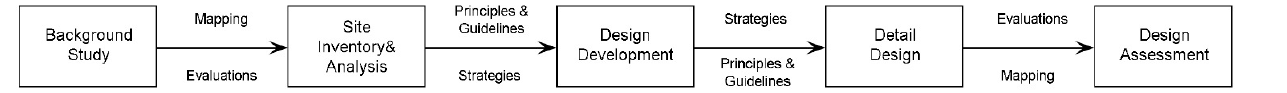
Figure 3. Stages of the approaches/design process (after [40]).